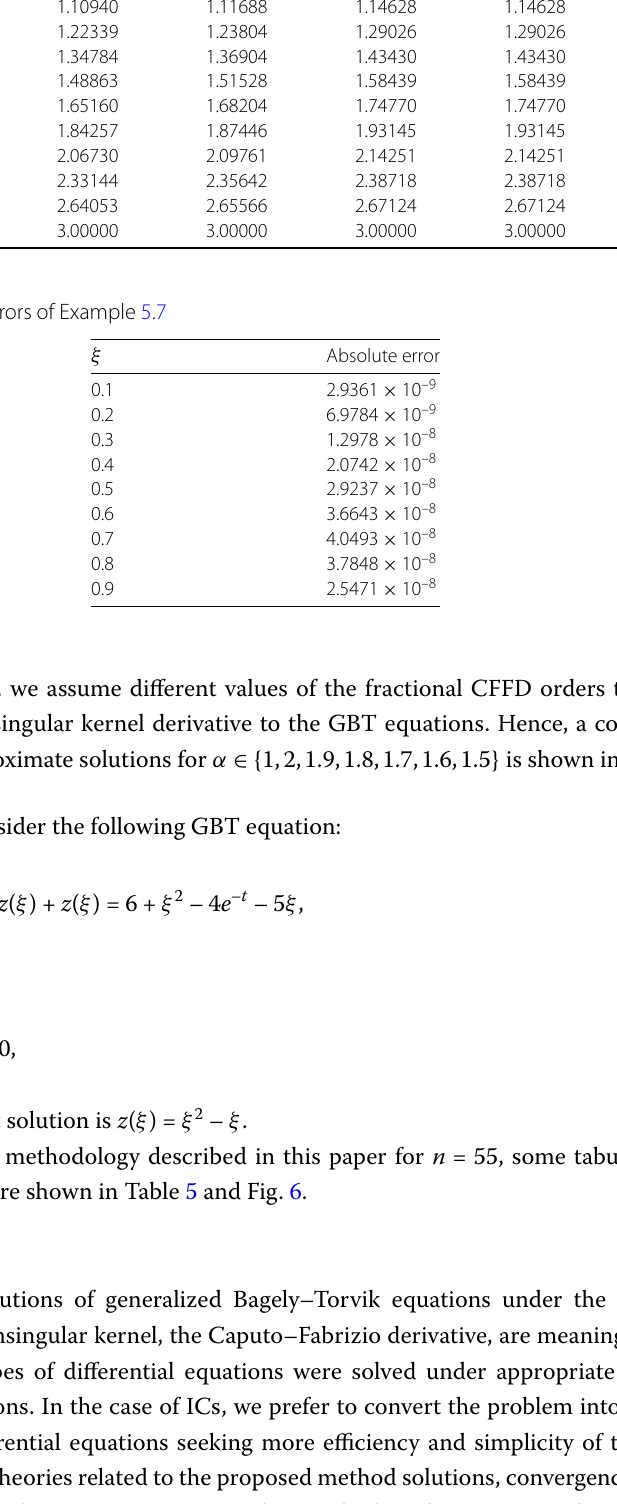
Table 4 Comparison of MRKHS solutions for different values of α for Example 5.6 ξ α = 2 α = 1.9 α = 1.8 α = 1.7 α = 1.6 α = 1.5 0.0